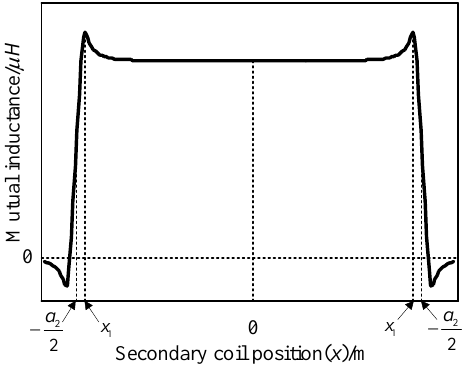
Figure 5. The curve of M ks versus position variation of the secondary coil.